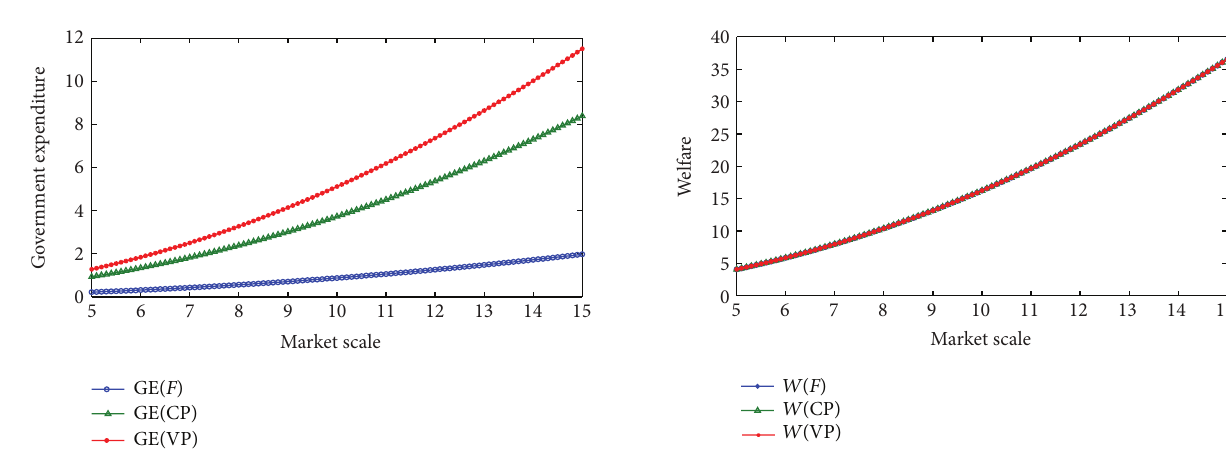
Figure 6: Three tools comparison on government expenditure under the change of market scale 𝛼 .